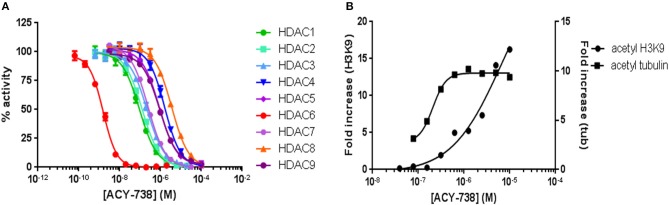
ACY-738 is a selective inhibitor or HDAC6. ACY-738 inhibits HDAC6 with a potency of 1.5 nM and HDAC1 (the next most affected target) with a potency of 93 nM (A). In a cell based assay in HCT-116 cells ACY-738 Induces tubulin acetylation (a marker of HDAC6 inhibition) at 800 nM, whereas histone acetylation (a marker of Class 1 HDAC inhibition) at that concentration is minimal (B).